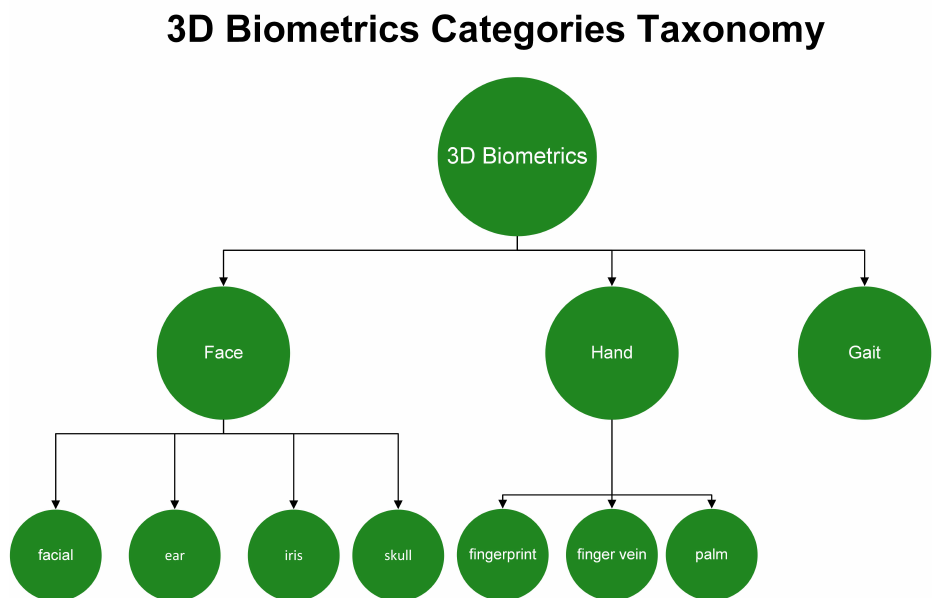
Figure 6. Three-Dimensional (3D) Biometrics